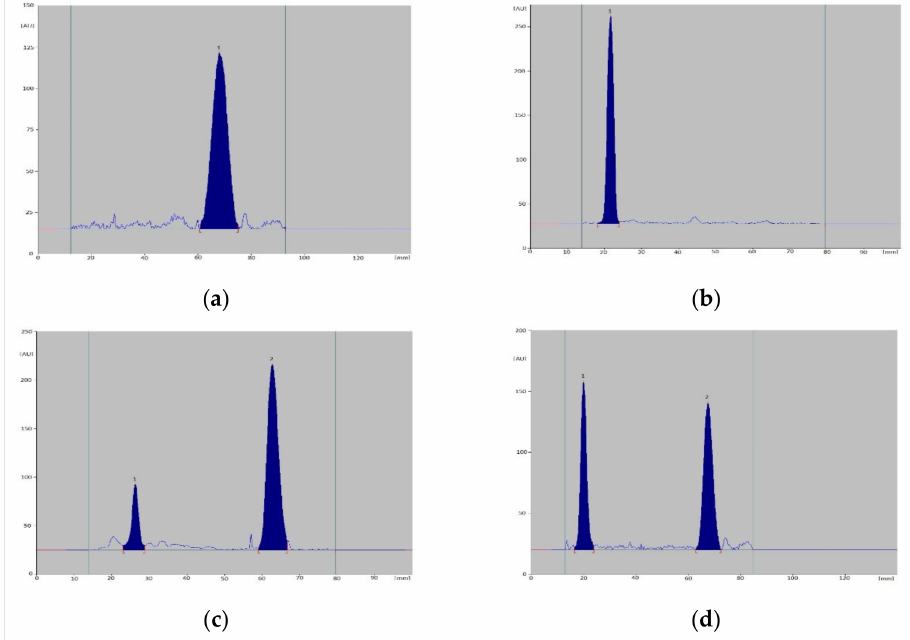
Figure 6. An example of sample densitograms registered for dietary supplements: Product A (( a ); 1—D 3 ), Product C (( b ); 1—K 2 ), Product F (( c ); 1—K 2 , 2—D 3 ) and Product K (( d ); 1—K 2 , 2—D 3